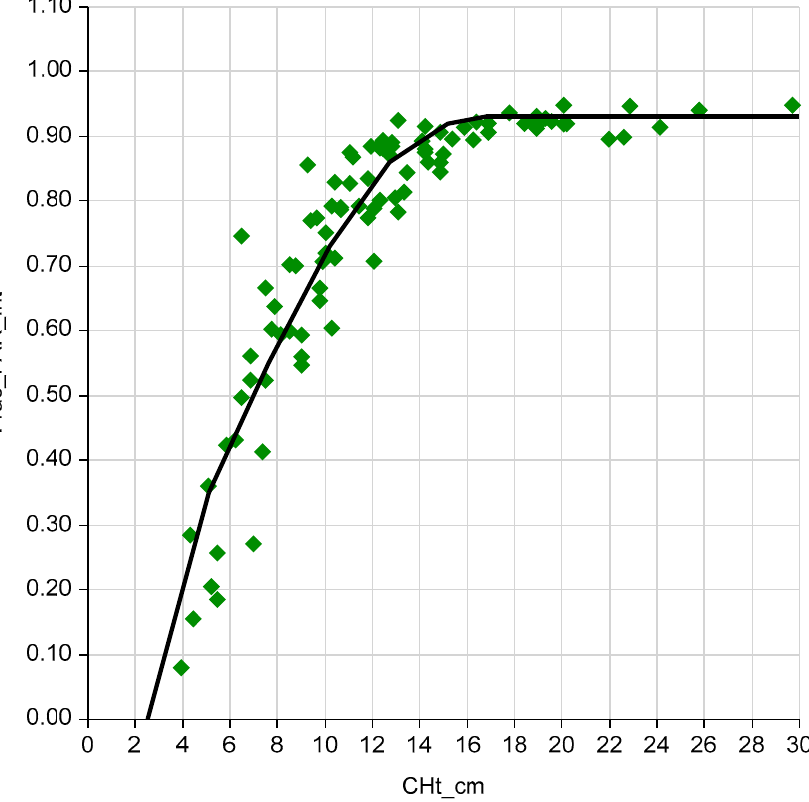
Figure 3. Interception of photosynthetically active radiation (LI, fraction of ambient PAR above canopy) in May and June, relative to pasture compressed height (CHt, cm).